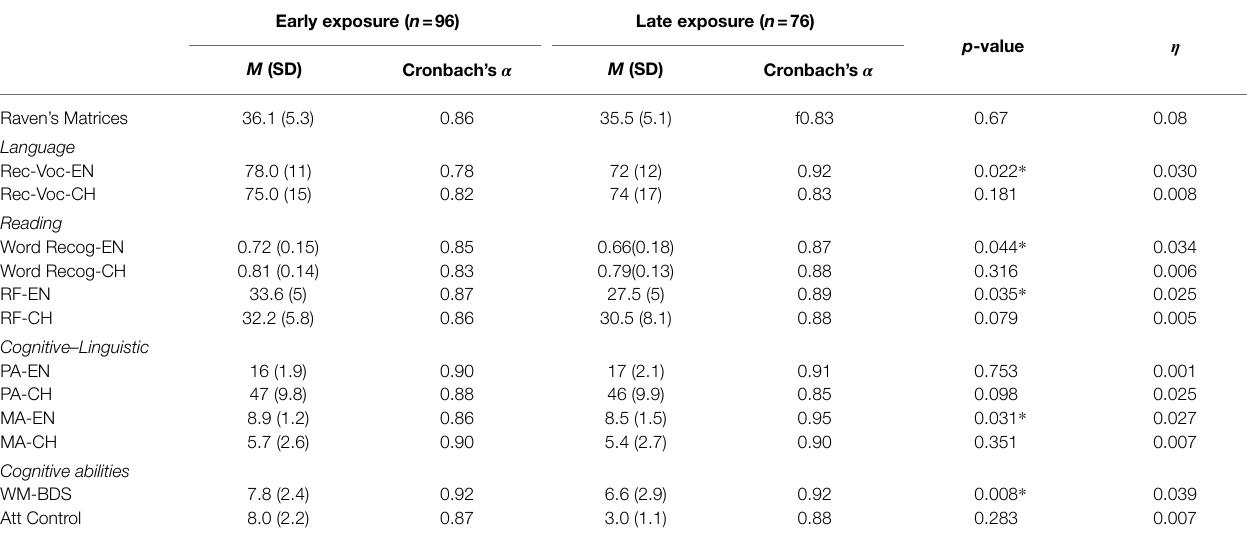
TABLE 3 | Descriptive statistics by tasks for grade 6: early vs. late exposure to